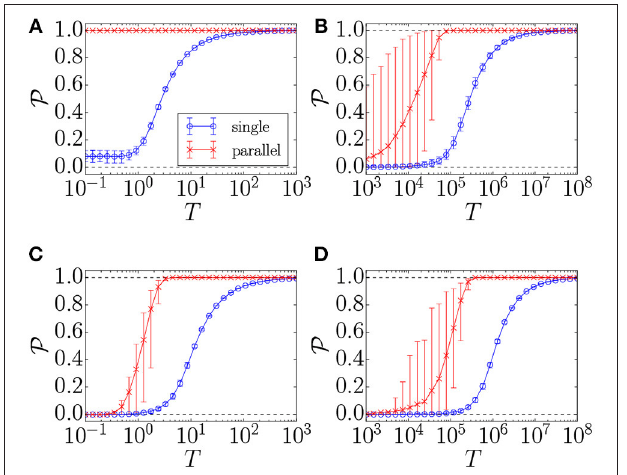
FIGURE 1 | Mean single-trial and parallel-trial acceptance probabilities ( P ) vs. the temperature ( T ), for four problem classes: (A) 2D-bimodal, (B) 2D-Gaussian, (C) SK-bimodal, and (D) SK-Gaussian. Error bars are given by the 5th and 95th percentiles of the acceptance probabilities in the configuration space. A constant-temperature Monte Carlo simulation has been run for 10 5 sweeps to thermalize, after which the acceptance probabilities are measured for 5 · 10 3 sweeps. For each problem class, the simulation has been performed on 100 problem instances of size N = 64 with 10 repeats per problem instance. The horizontal dashed lines show the minimum and maximum attainable probabilities, zero and one, respectively. Acceptance probabilities for the parallel-trial scheme approach unity as a function of simulation time considerably faster than in the single-trial scheme.